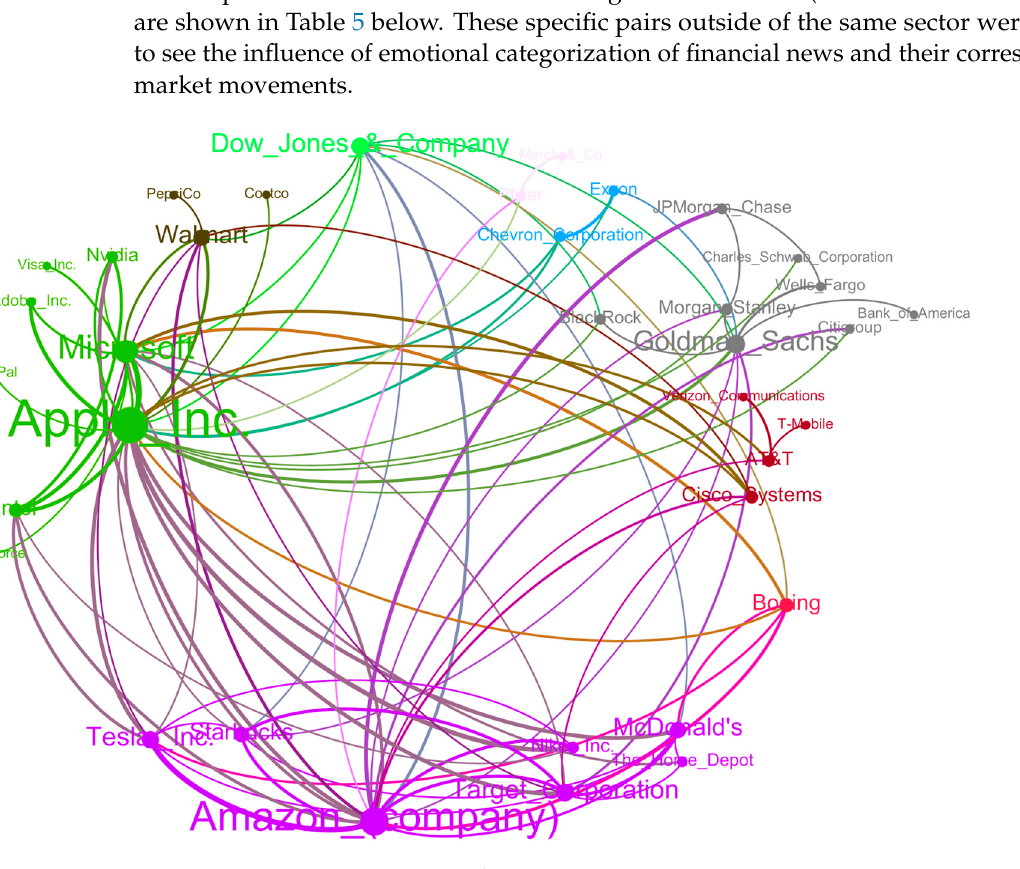
Table 4. Correlation between sectors.